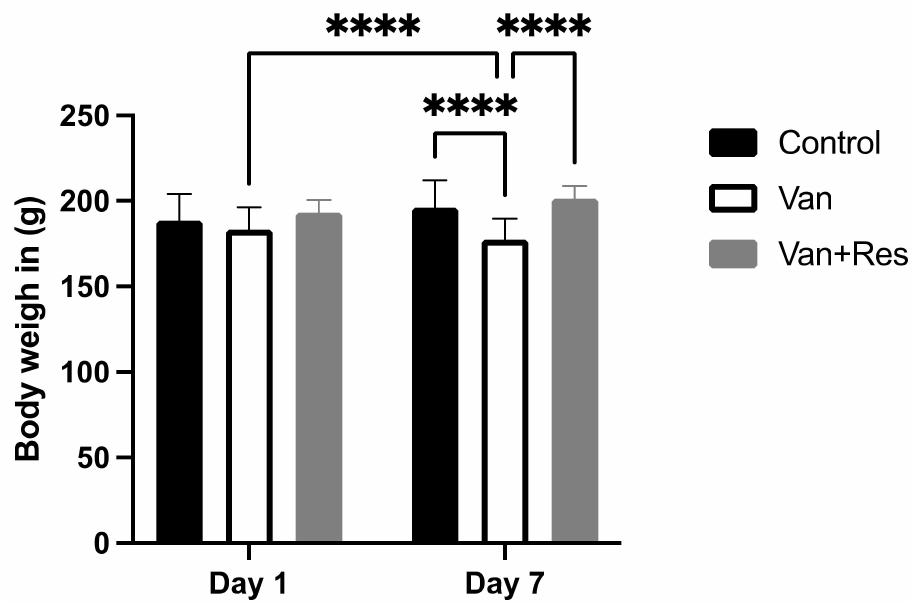
Figure 1. The effect of the resveratrol and vancomycin administration on the animals’ body weights during the experiment. **** p <